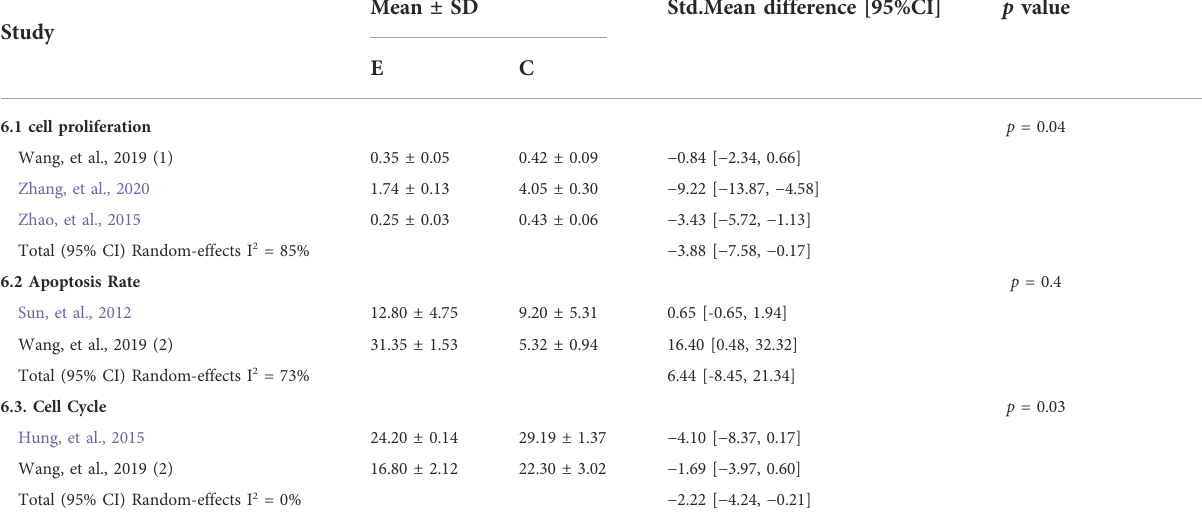
TABLE 6 Analysis of cell proliferation in preclinical studies in